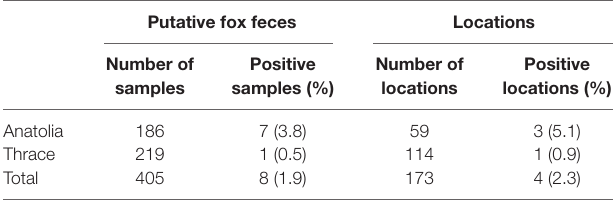
Table 1 | Detection of Echinococcus multilocularis DNA in putative fox fecal samples collected in the environment in